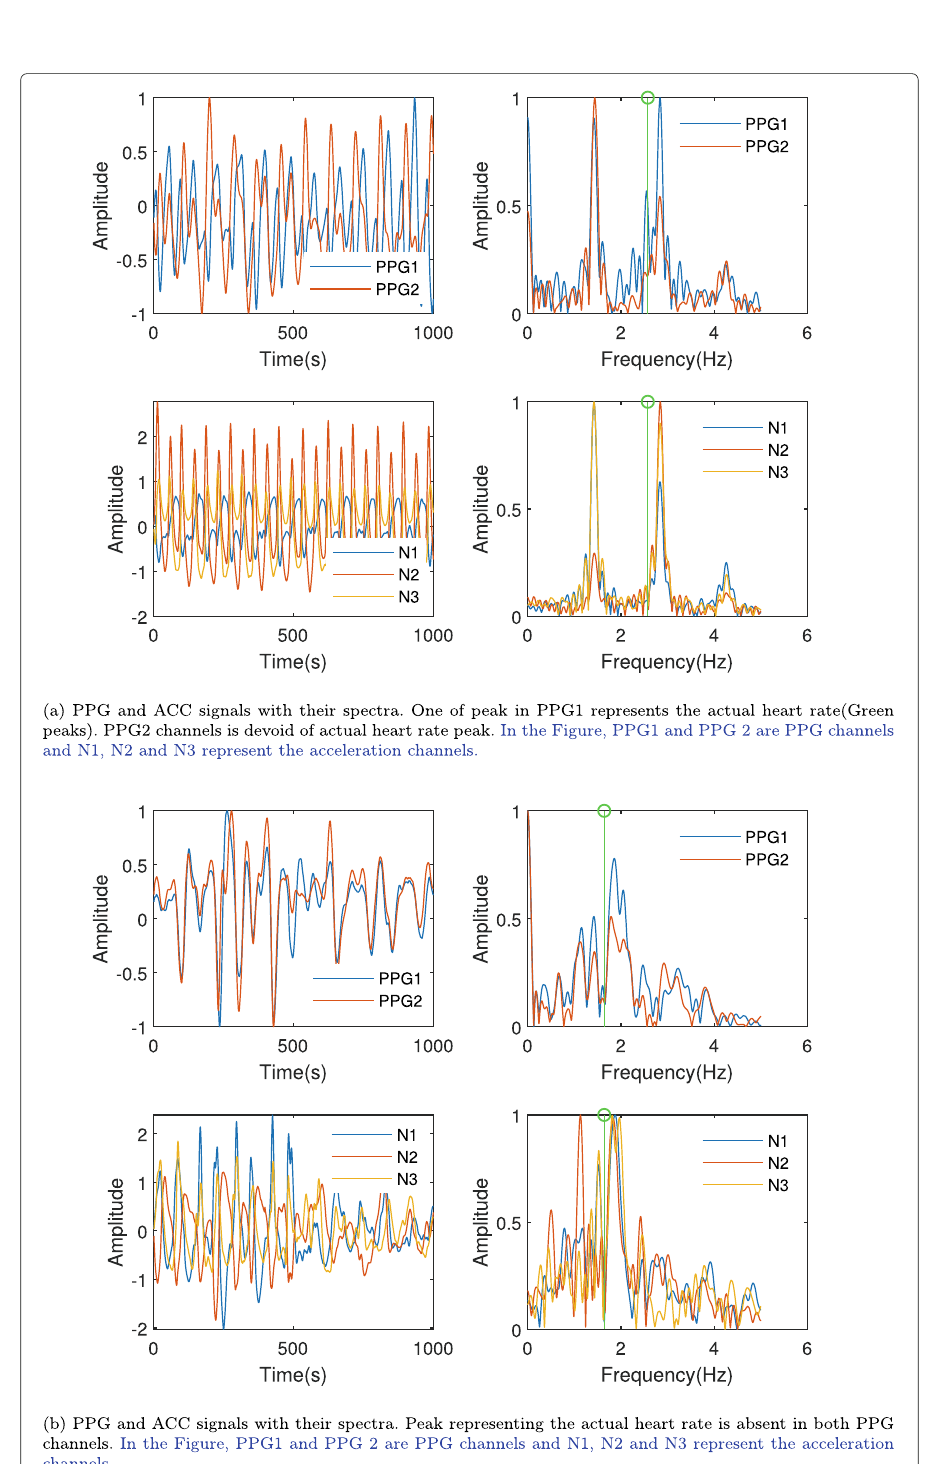
Fig. 3 An example showing PPG affected strongly by